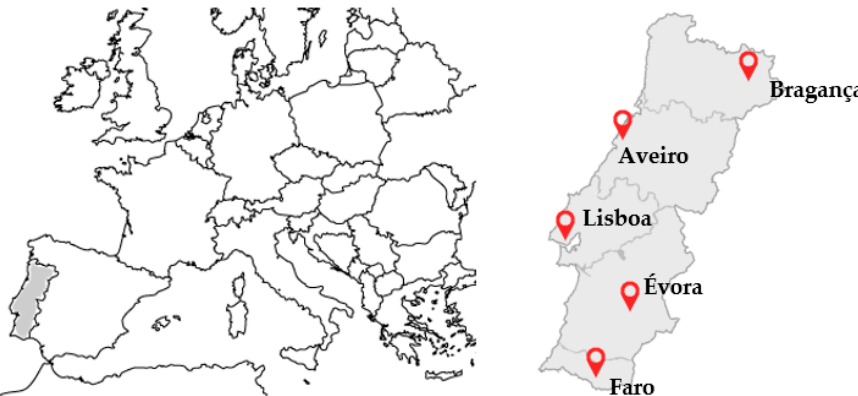
Figure 4. Location of the cities considered in the dynamic simulations within the Portuguese territory. Table 1. External weather characteristics of the climates considered in the dynamic simulations.